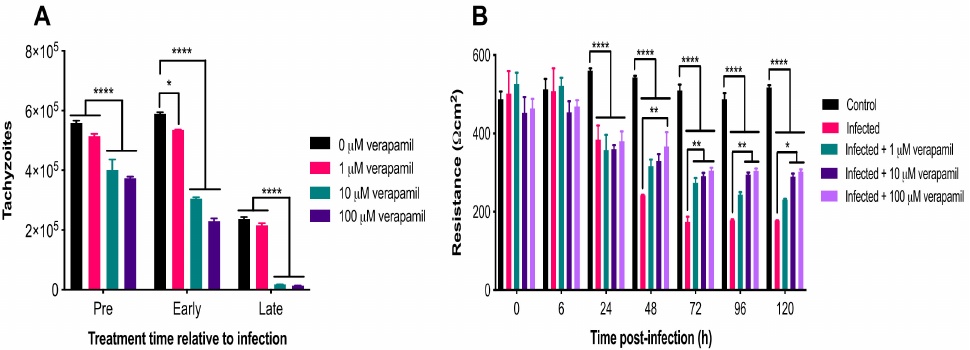
Figure 8. Verapamil inhibited parasite growth and improved barrier function. ( A ) Early treatment with all three concentrations and pre-infection treatment with two concentrations (10 and 100 µ M) of verapamil significantly decreased tachyzoite numbers, compared to vehicle control. Late treatment with 10 and 100 µ M of verapamil also significantly decreased tachyzoite numbers, compared to vehicle and to 1 µ M of verapamil. ( B ) No di ff erences were detected in resistance between control and infected cells treated with any concentration of verapamil from 0–6 hpi ( p > 0.05). From 24–120 hpi,